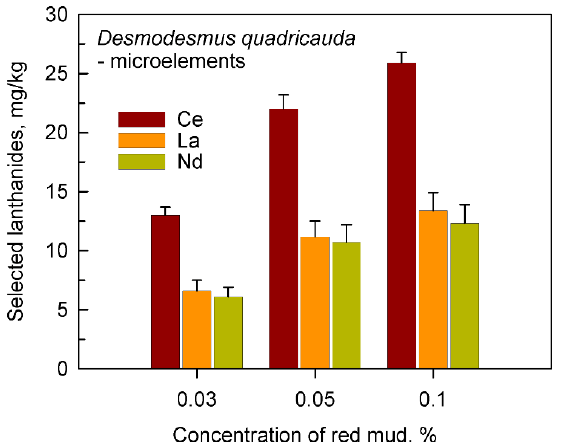
Figure 6. The content of cerium, lanthanum and neodymium in cells of Desmodesmus quadricauda grown in incomplete nutrient medium lacking added microelements in the presence of 0.03, 0.05 and 0.1% ( w/v ) of red mud.